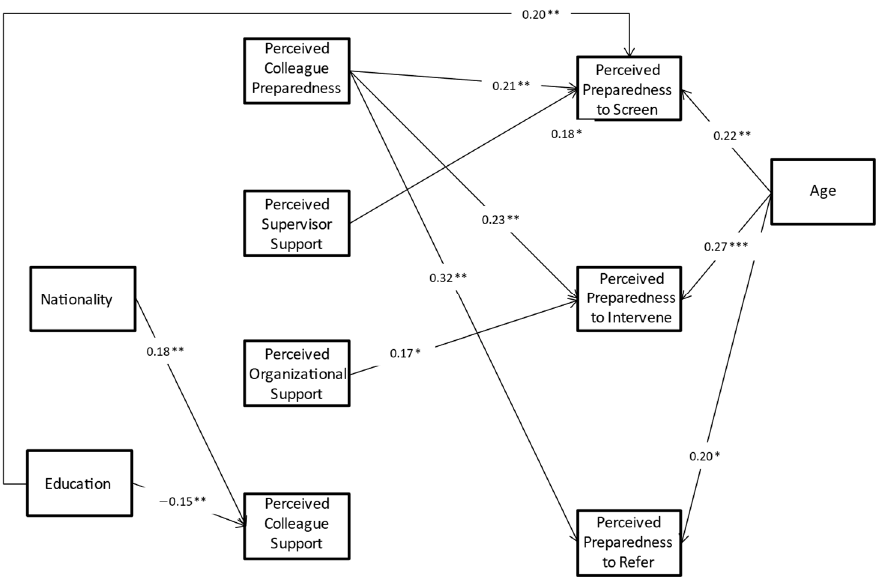
Figure 2. Path analysis graphic model results, standardized coefficients. * Only significant ( p < 0.05) estimates are shown. * p < 0.05, ** p < 0.01, *** p < 0.001.